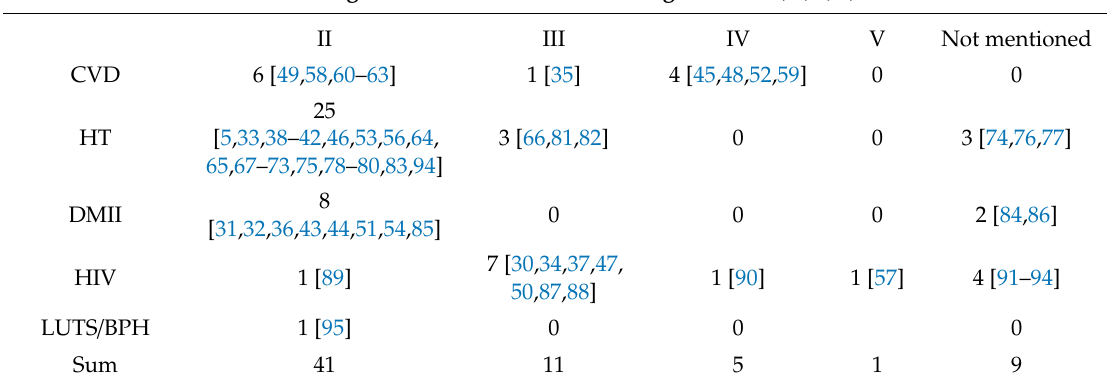
Table 3. Visualization of number of active ingredients contained in a polypill. Written in the table are numbers of the studies with the given characteristics (disease and number of active ingredients in the